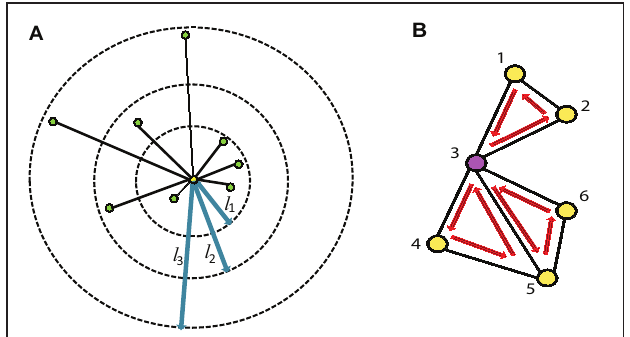
FIGURE 2 | (A) The degree of the node, highlighted in yellow, is the count of all the green nodes connected to it (i.e., 8), while the varying distance degree is the counts of all the connected nodes in each of the bins defined by the three edge length thresholds ( l 1 , l 2 , l 3 ) marked in blue. In this example the varying distance degrees of the yellow node are { 4 , 2 , 2 } . (B) Shows all the distinct 3-cycles that containing the node